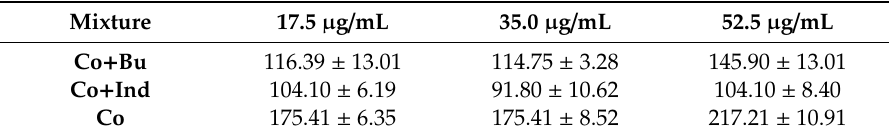
Table 2. Percentage of release of nitrites in LPS RAW 264.7 activated cells in respond to stoichiometric mixtures and